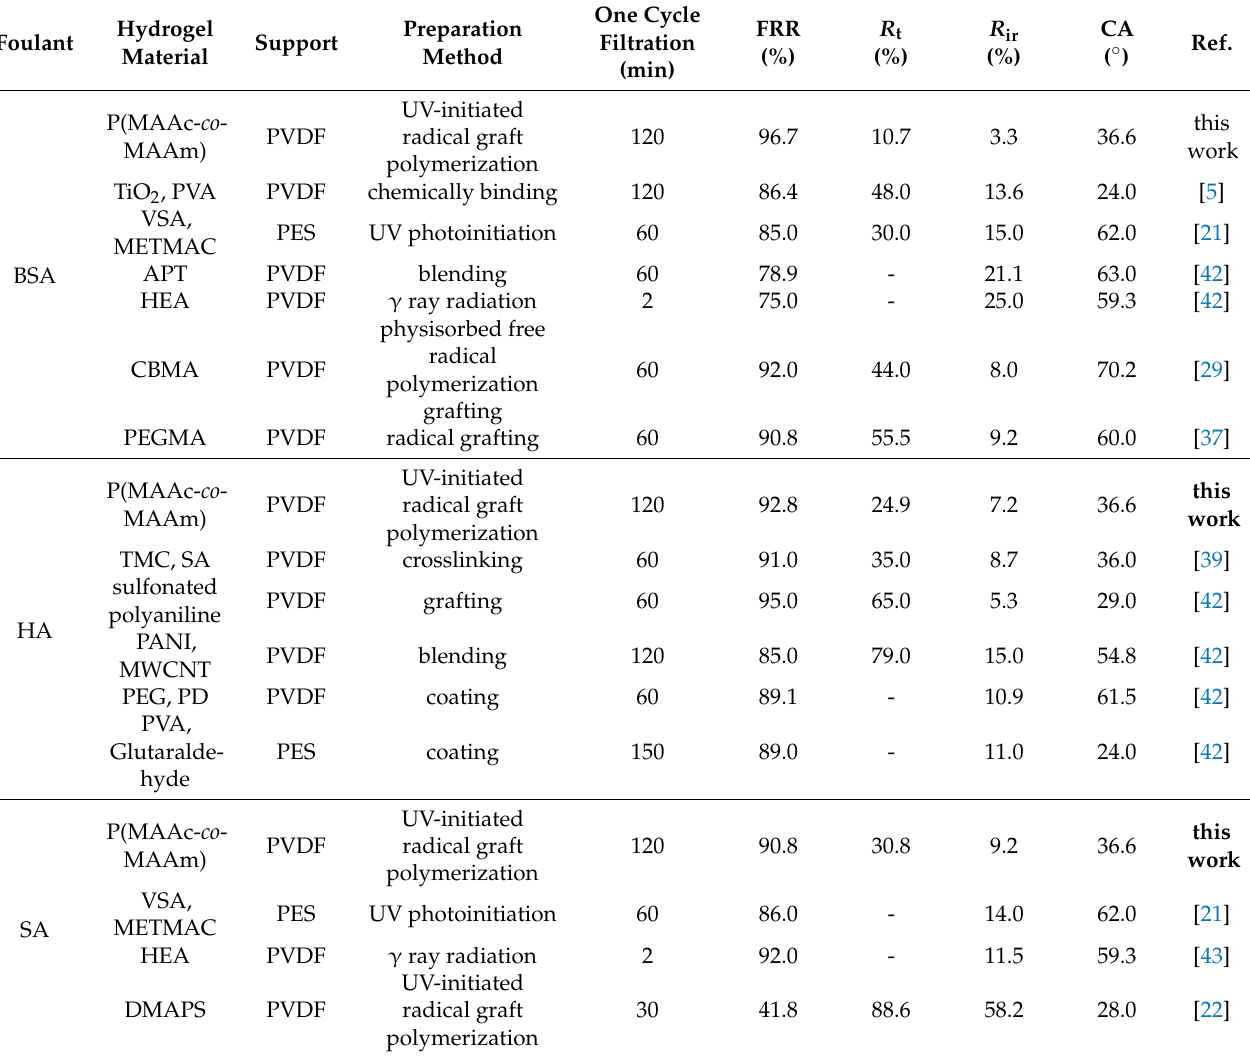
Table 2. Comparison of antifouling ability of hydrophilic modified membranes in literature and M2-2 membrane in this work for three